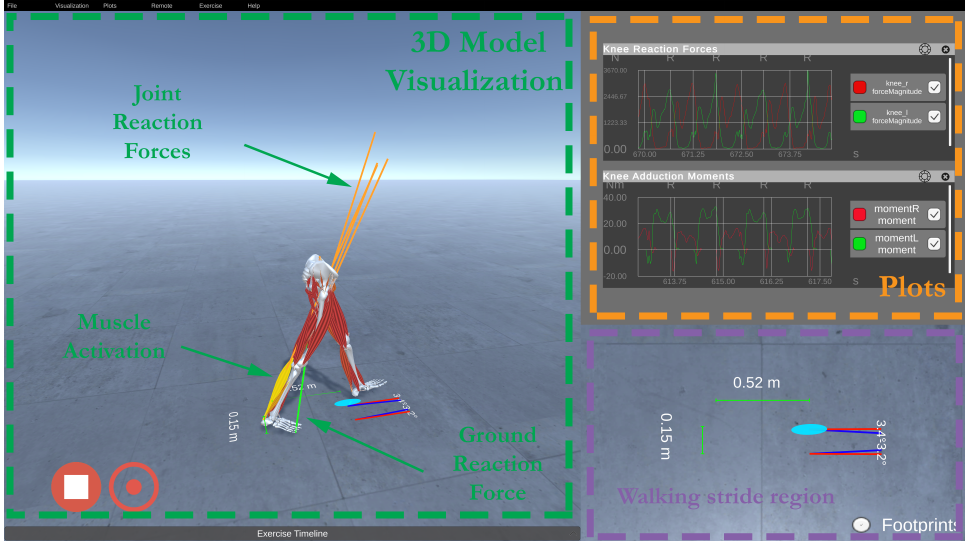
Figure 4. Visualization front-end composed of a musculoskeletal visualizer, real-time plotting, and footprint